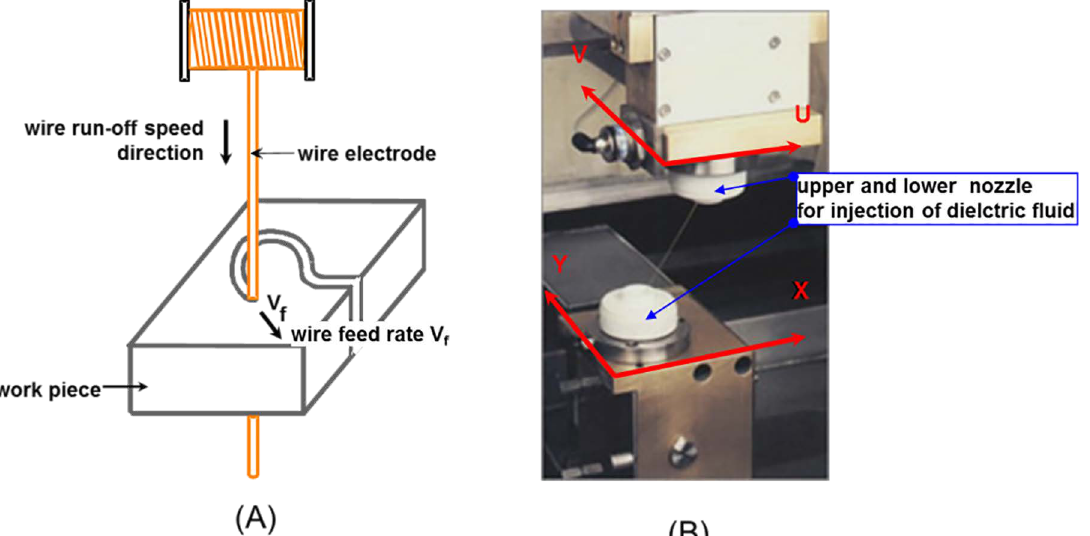
Figure 1. (A) schematic picture of a WEDM operation method and (B) WEDMachine used in this work depicting the nozzles to inject the de-ionized water